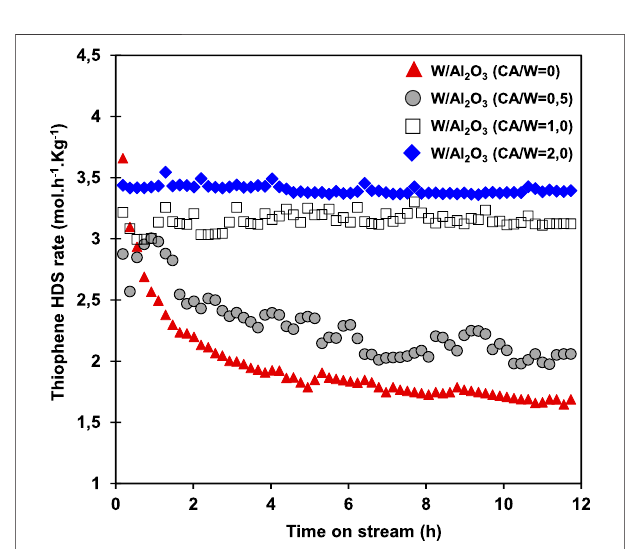
FIGURE 2 | Variations of catalytic behavior according to CA content. Stability over time of the HDS rate of the W (CA/W (cid:1) x)/Al 2 O 3 series of